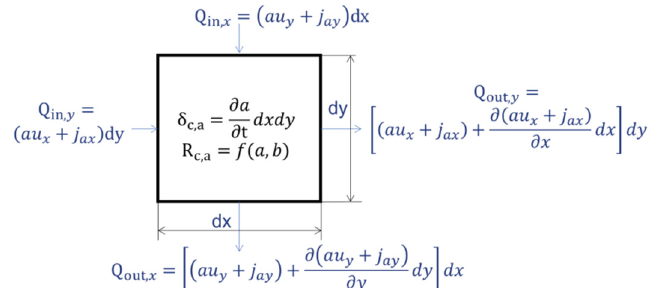
Figure 3. Take component ‘ a’ as an example, mass balance at one dot . dx and dy are the length and width of the dot , respectively. Q in,x , Q out,x are the mass feed and outlet in x direction of a , and similar in y direction. δ c,a represents the a accumulated molar amount per unit time on this dot . R c,a represents the molar amount of a generated by reaction per unit time on the dot , which is calculated by Equation (1).